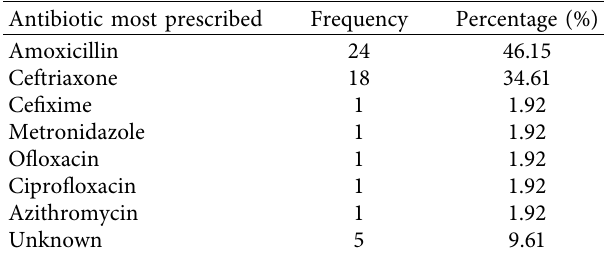
Table 2: Antibiotics frequently prescribed by medical doctors.